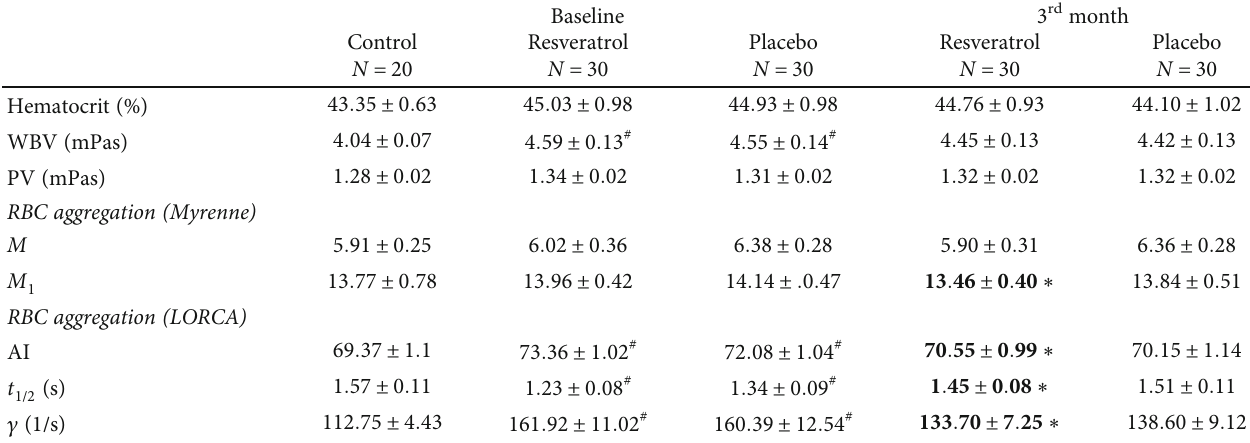
Table 2: E ff ect of resveratrol on hemorheological parameters.